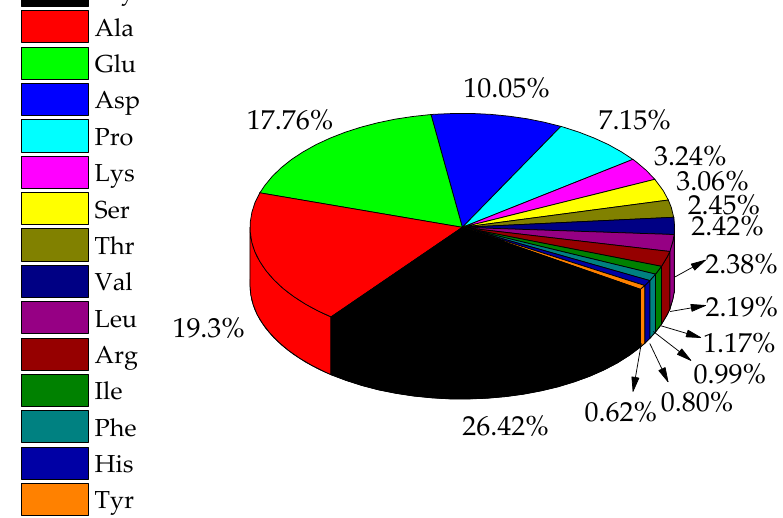
Figure 12. Amino acid composition (molar ratio) of the EPS from H. smyrnensis WMS-3.